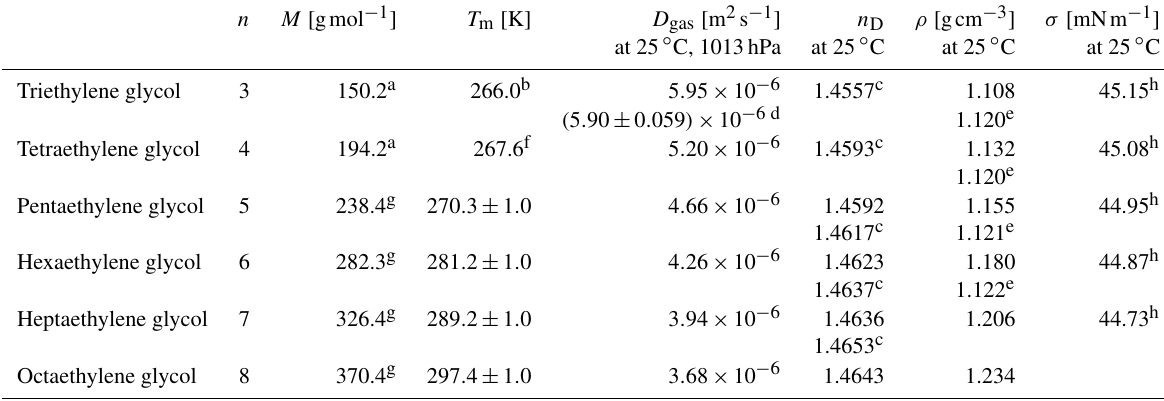
Table 1. Physical properties of the polyethylene glycols (H − ( O − CH 2 − CH 2 ) n − OH) used in this study: number, n ; molar mass, M ; melting temperature, T m ; gas phase diffusivity in air, D gas , estimated as described in Bird et al. (2007) using T c from UManSysProp (Topping et al., 2016); refractive index, n D ; surface tension, σ . If not indicated otherwise, the data are from this study. n M [gmol − 1 ]